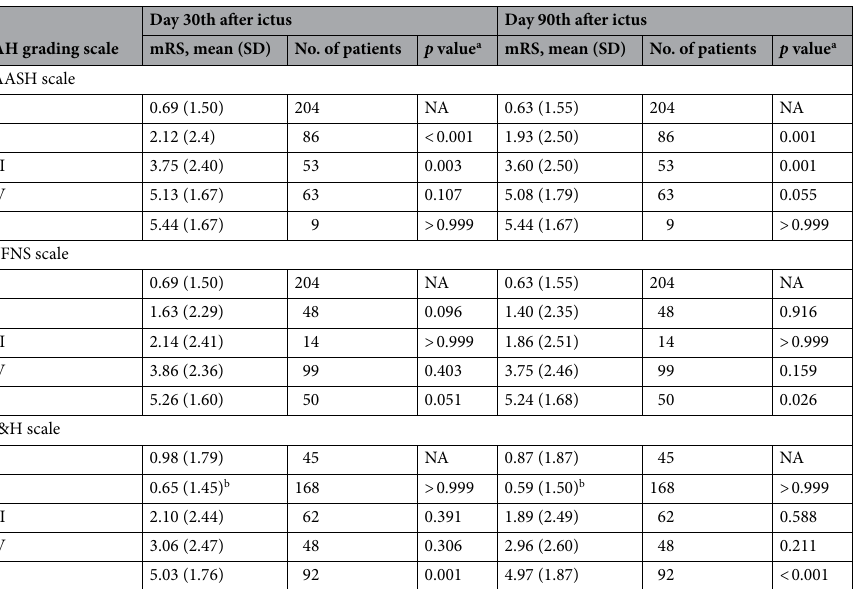
Table 3. Comparison of outcomes between the intergrades of the subarachnoid haemorrhage grading scales. H&H Hunt and Hess, mRS modified rankin scale, NA not applicable, No. number, PAASH prognosis on admission of aneurysmal subarachnoid haemorrhage, SAH subarachnoid haemorrhage, SD standard deviation, WFNS World Federation of Neurological Surgeons. a Probability values were obtained by comparing the